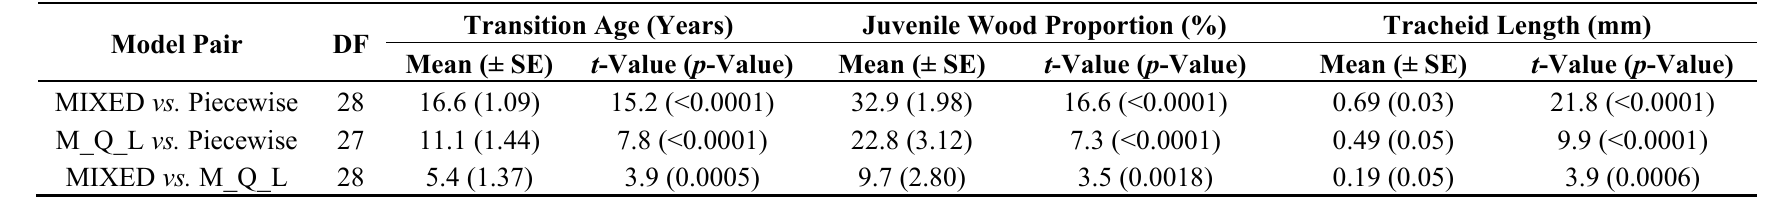
Table 6. Average and standard error (SE) for differences at breast height (30 trees) in transition age, juvenile wood proportion, and tracheid length at the time of transition between each of the three-paired models. Estimates for each tree were compared across paired models using paired t -tests with Bonferroni adjustment ( p < 0.05/30 =